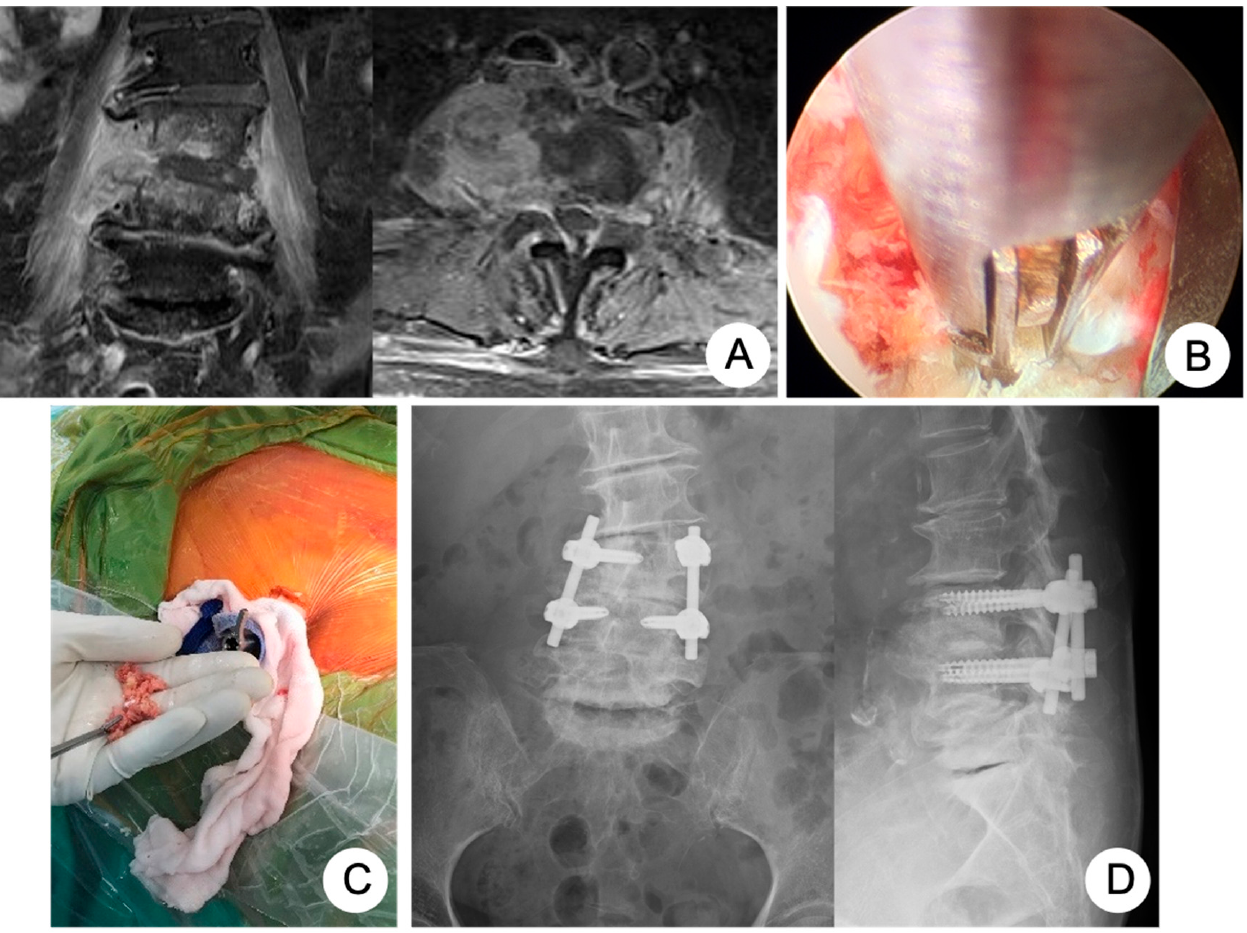
Figure 1. An 81-year-old female had the comorbidity of chronic kidney disease, stage 4, caused by poor-controlled diabetes mellitus, hypertension with atrial fibrillation, and ovarian cancer history, suffering from infectious spondylodiscitis complicated with severe endplate destruction and psoas muscle abscess ( A ). We performed PEIDF composed of percutaneous endoscopic debridement ( B ) and allogenous bone grafting ( C ) through the working sheath and posterior percutaneous pedicle screw fixation at one level above and below under the guidance of fluoroscopy ( D ).